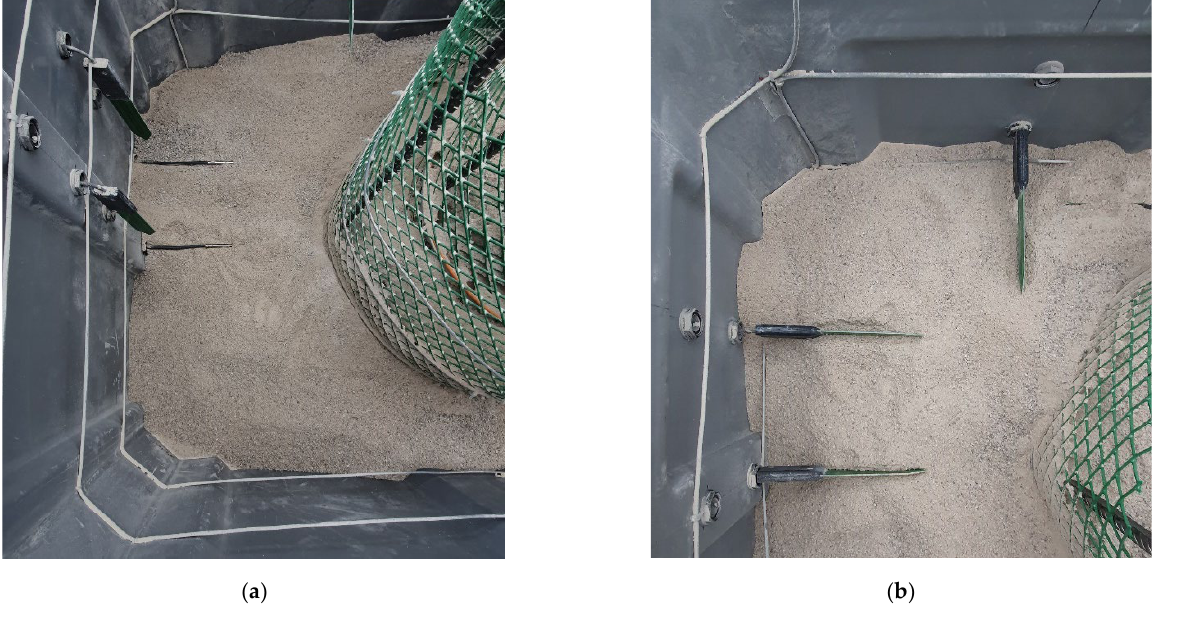
Figure 4. Laboratory experimental setup during the buildup process. PT1000 ( a ) and SMT100 ( b ).